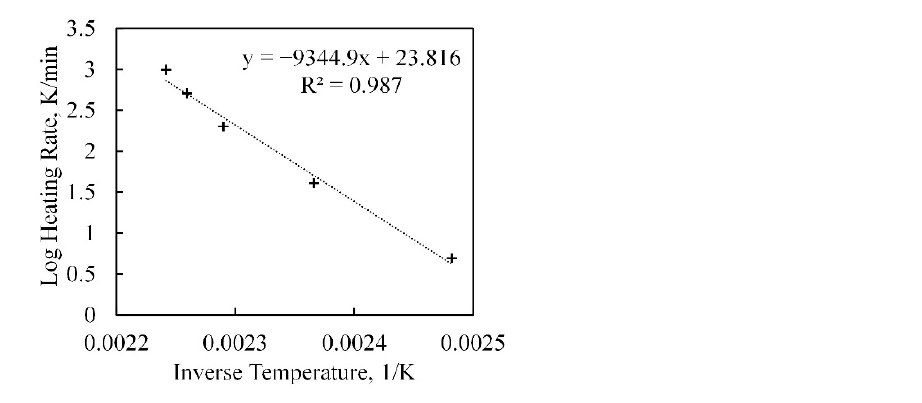
Figure 8. Arrhenius plot of log heating rate vs. inverse temperature for of 90% aqueous HAN sample with linear fit shown.